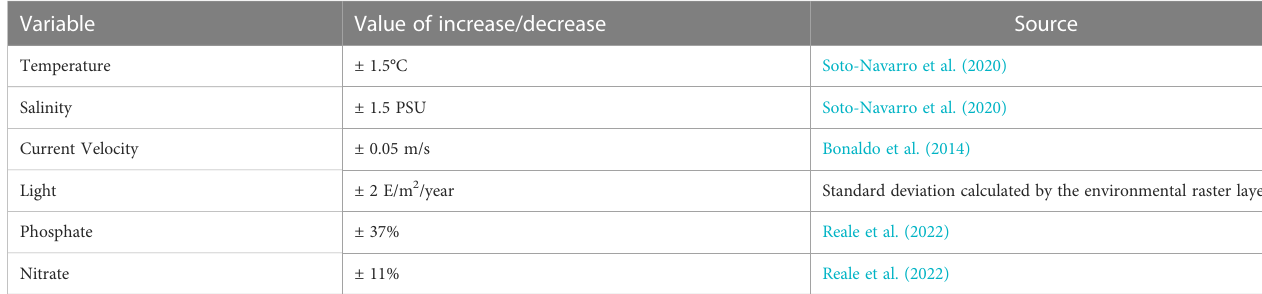
was computed at each location as the fraction of sensitivity runs in in SCE. Larger values of consensus correspond to smaller sensitivity.